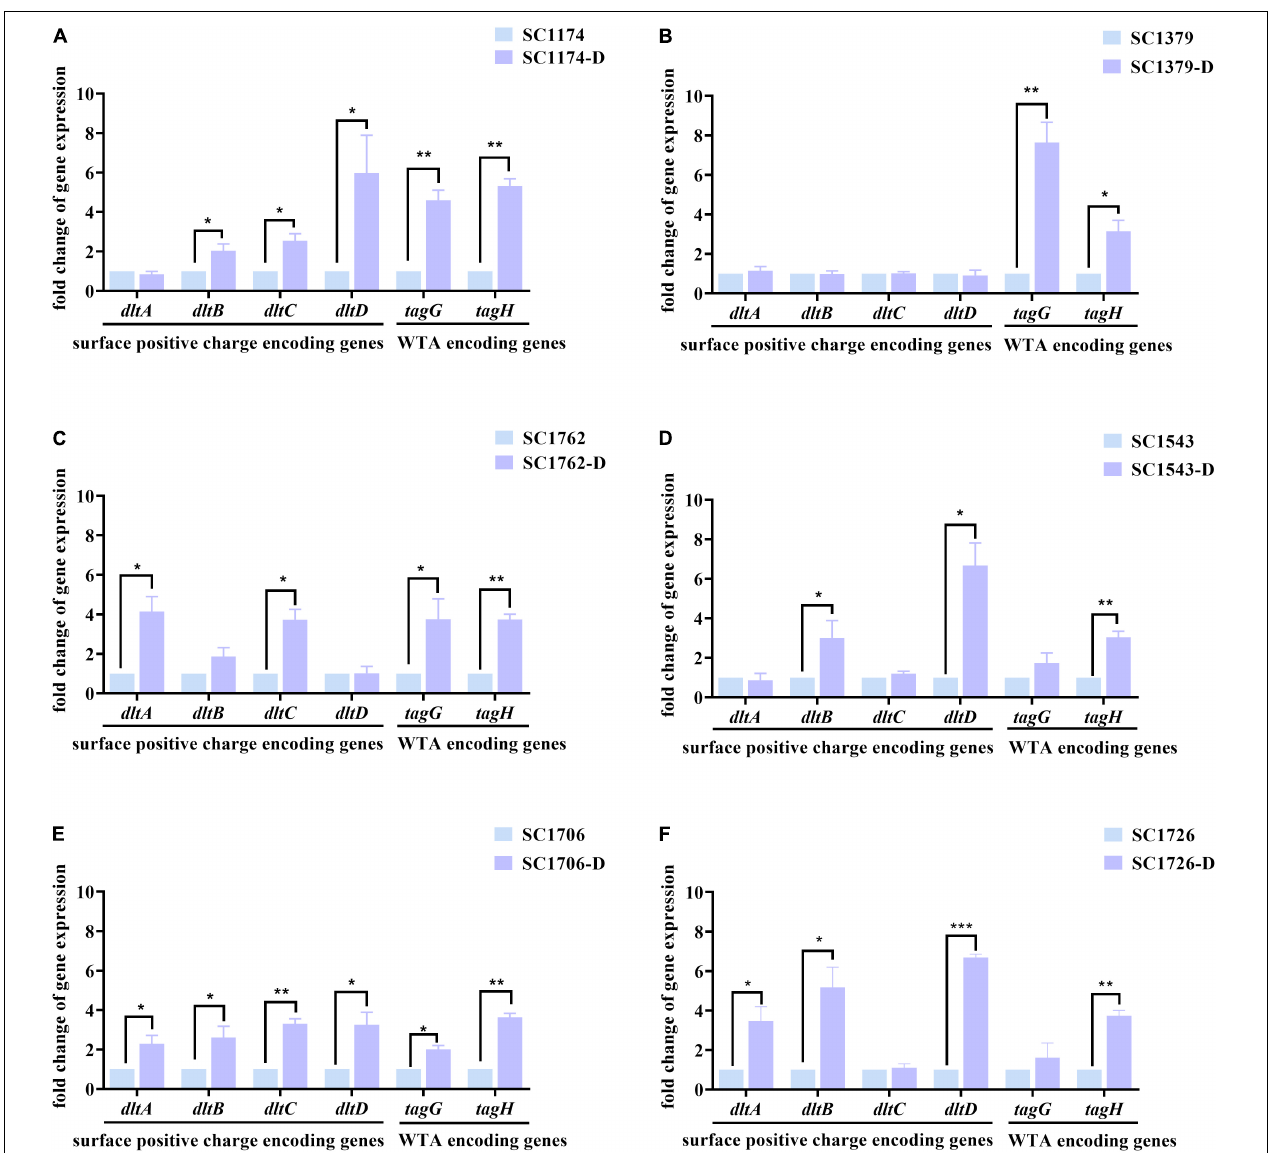
FIGURE 5 | Relative expression levels of dltABCD and tagGH in the parental strains and DAP-R mutants. Values were normalized based on the internal control gene, 16S rRNA ; data from the parental strain were normalized to 1 to allow the comparison of data across different samples. (A–F) show the expression levels of the surface positive charge-encoding genes in dltABCD and the cell-wall teichoic acid (WTA)-encoding genes in tagGH in SC1174, SC1379, SC1762, SC1543, SC1706, SC1726, and their corresponding evolved DAP-R mutants, respectively. Data represent the mean values from three independent experiments with error bars indicating standard deviations, and asterisks denote the significance of differences in expression by the paired Student’s t -test (* P < 0.05; ** P < 0.01; and *** P < 0.001).